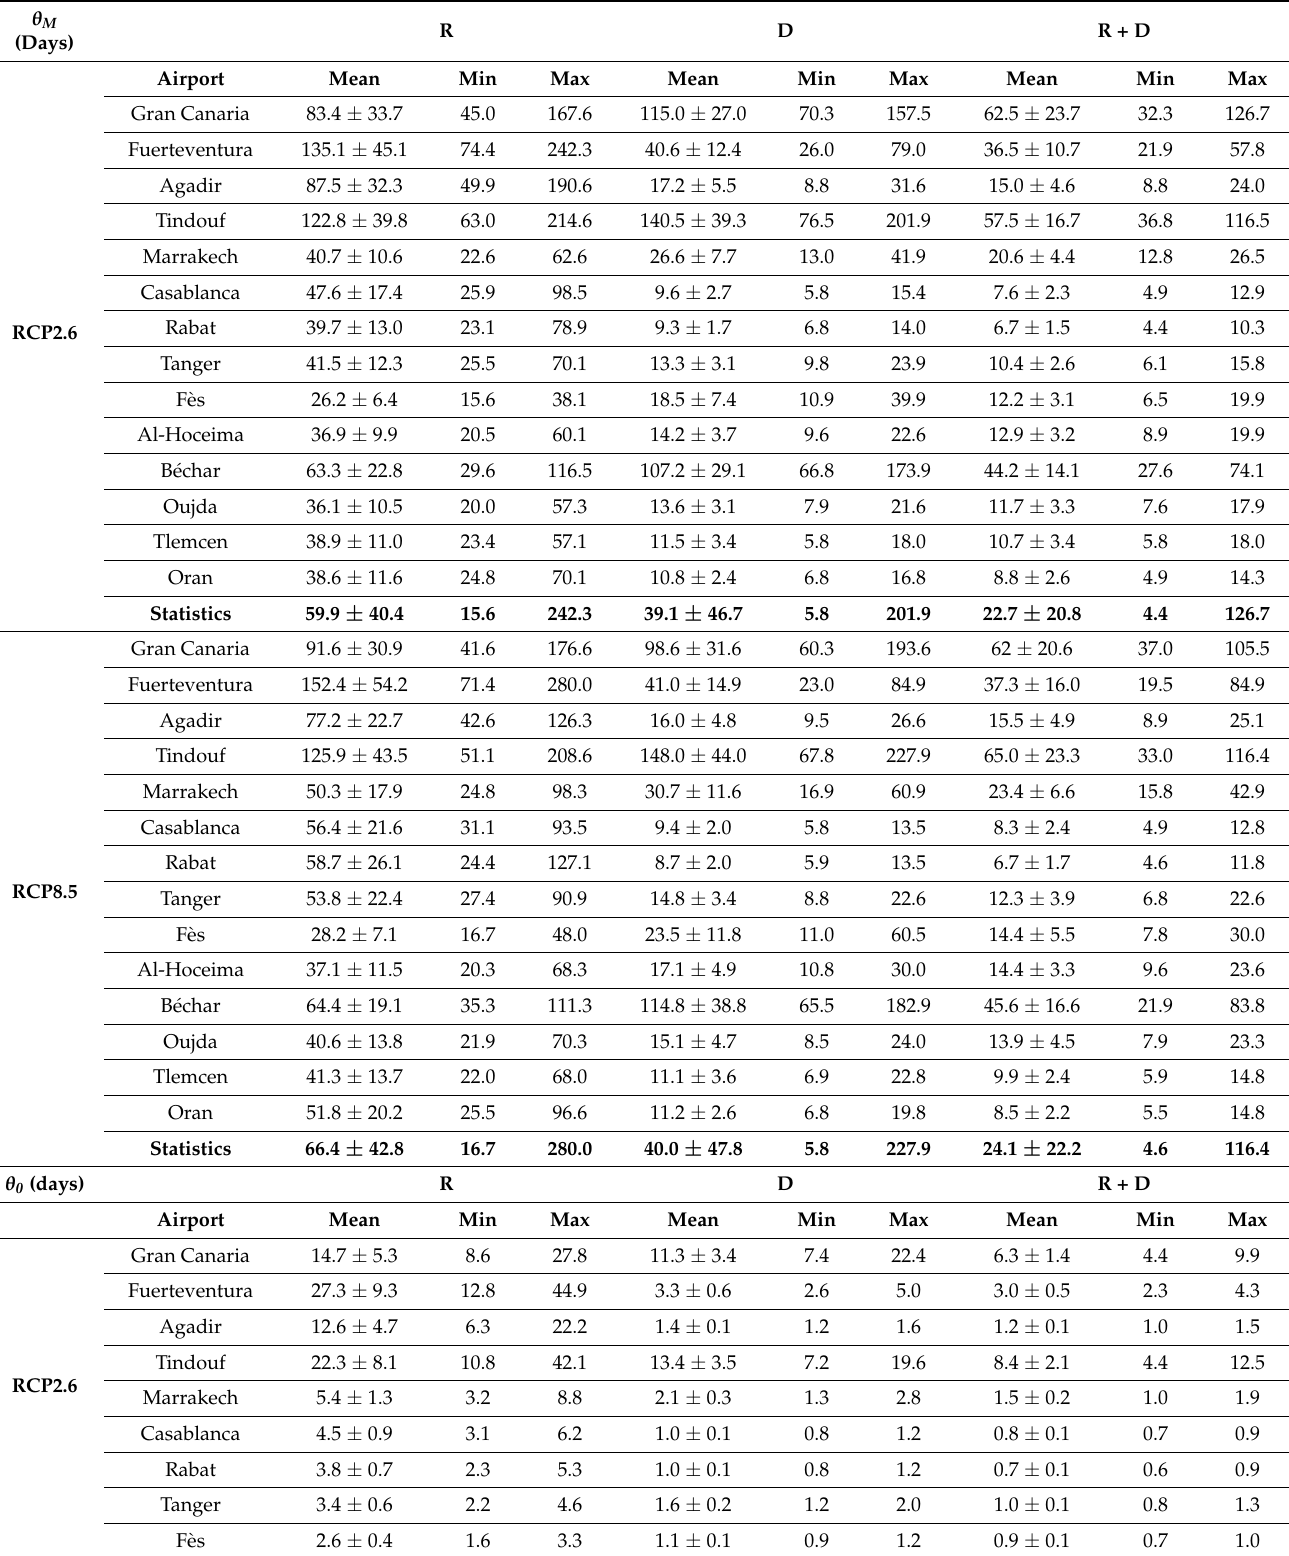
Table 5. Yearly mean, minimum and maximum values for maximum time θ M and mean time θ 0 (days) between events, considering all sites and according to both RCP scenarios between years 2006 and